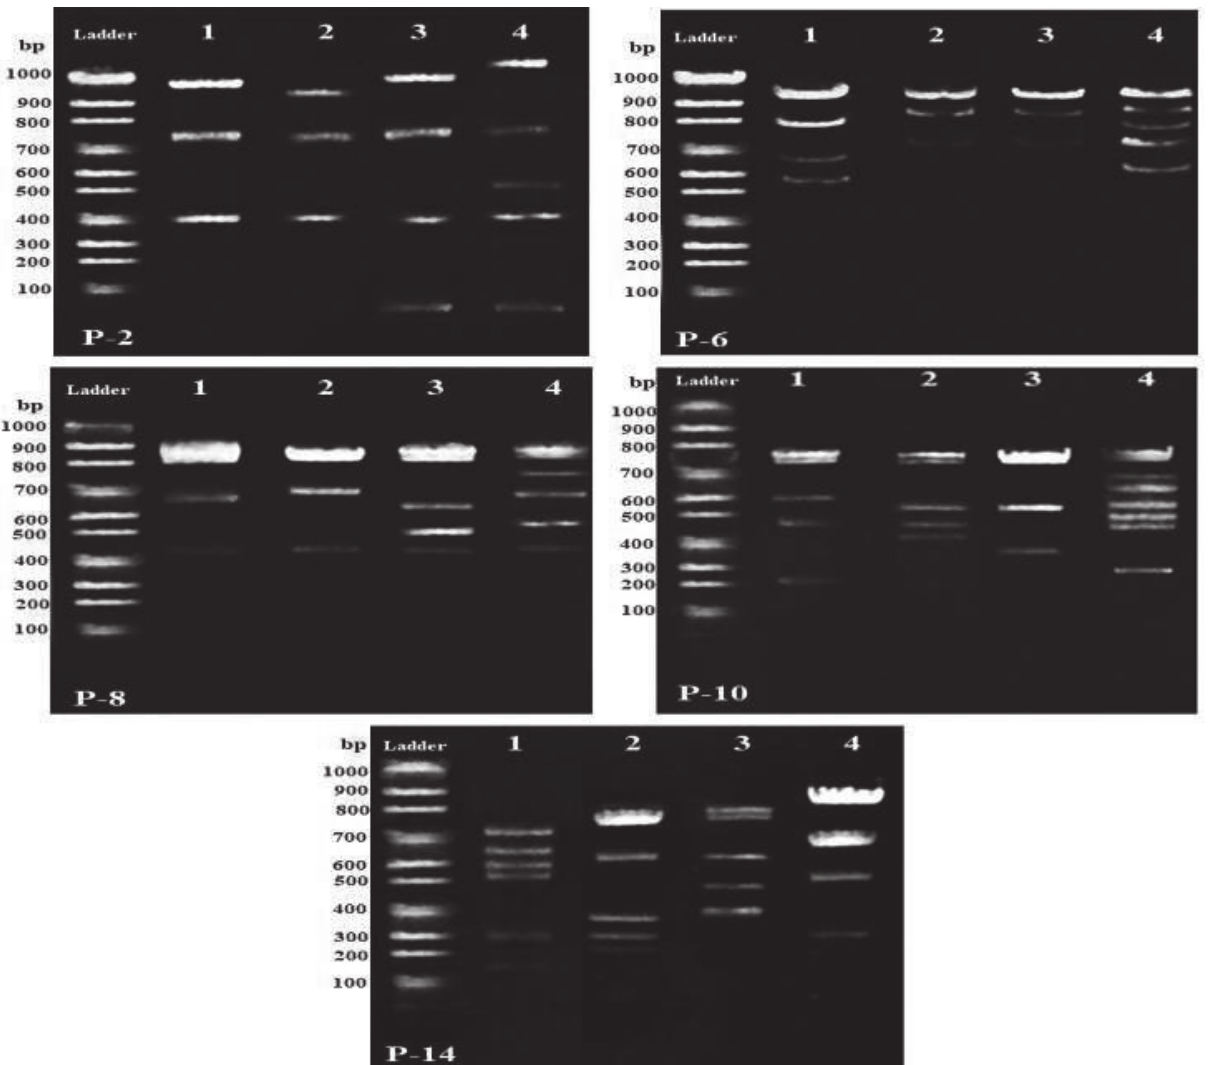
Figure 4. Amplified DNA banding patterns of genomic DNA isolated from non-exposed and EMR exposed seedlings of Zea mays for days of exposure times (Ex-1, Ex-3,and Ex-5) and analyzed by RAPD-PCR DNA using five random primers (P-02, 06, 08, 10, and 14). Lanes 1–4 represented the days of exposure times (Ex-0, Ex-1, Ex-3,and Ex-5),